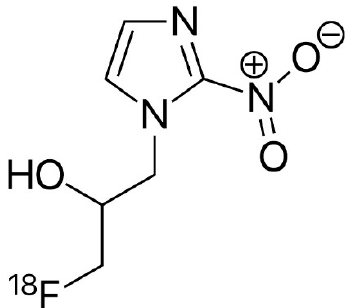
Figure 3. Chemical structures of 18 F-FMISO.